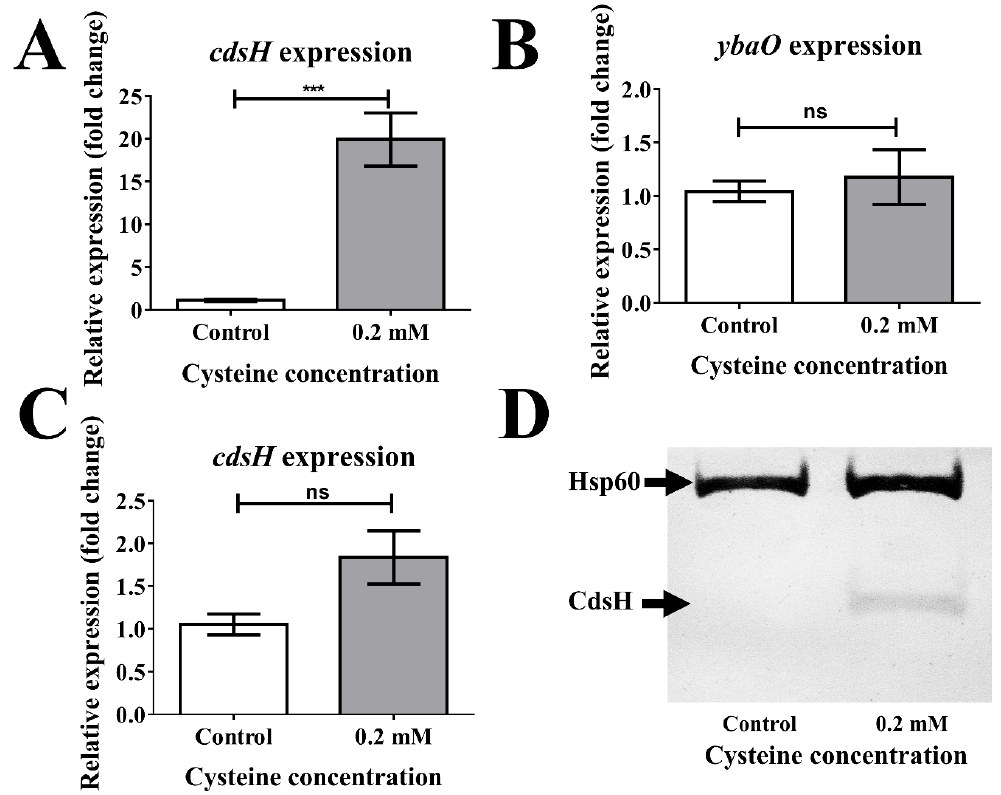
Figure 2. Aerobic cdsH and ybaO expression in response to cysteine. S. Typhimurium strains were grown in M9-glucose to OD 600 0.4–0.5 prior to supplementing with cysteine (0.2 mM, final concentration) or water (control). After 20 min incubation, bacteria were harvested, and an RT–PCR assay was performed as described in Materials and Methods ( A – C ). ( A ) cdsH expression in the WT context. ( B ) ybaO expression in the WT context. ( C ) cdsH expression in the ∆ ybaO context. A-C, Mann–Whitney test (error bars represent standard error of the mean, n = 4, ns, no significative; ***, p < 0.001). For the Western blot assay ( D ), the S. Typhimurium cdsH -3 × FLAG was cultured in M9-glucose to OD 600 0.4–0.5 prior to supplementing with cysteine (0.2 mM, final concentration) or water (control). Hsp60 was used as a control load, as described [30]. After 1 min incubation, bacteria were harvested, and the Westen blot assay was performed as described in Materials and Methods (a representative result of n =